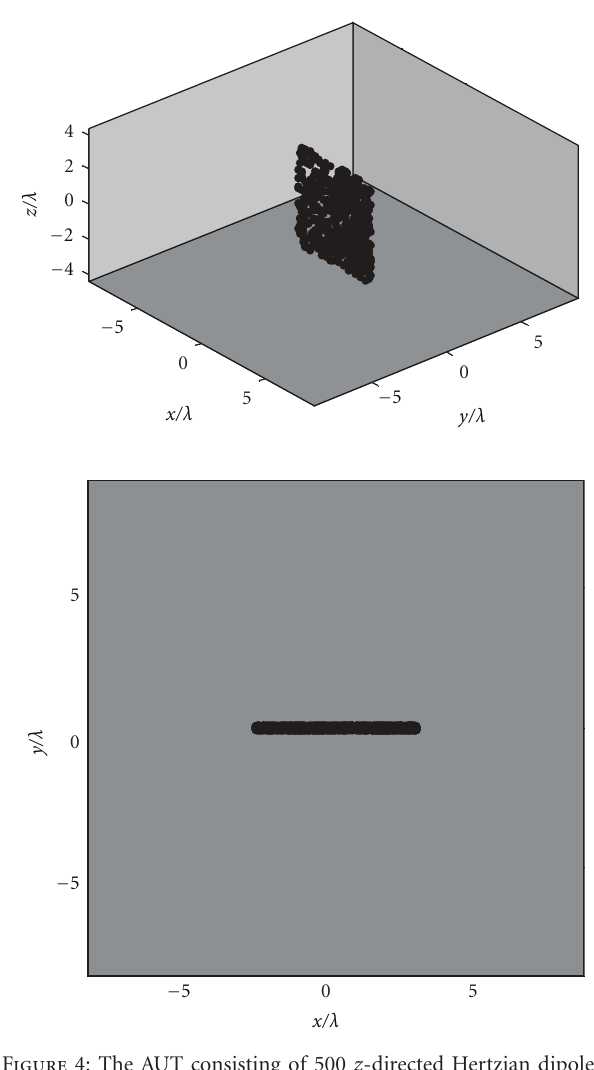
Figure 4: The AUT consisting of 500 z -directed Hertzian dipoles randomly distributed in a box with dimensions − 2 . 8 λ < x < 2 . 8 λ , − 0 . 03 λ < y < 0 . 03 λ , and − 2 . 8 λ < z < 2 . 8 λ , so that R = 4 λ . min = (cid:2) φ ( θ (cid:2) α where (cid:2) φ 0 , φ 0 ). The direction 2 of the dipole for 0